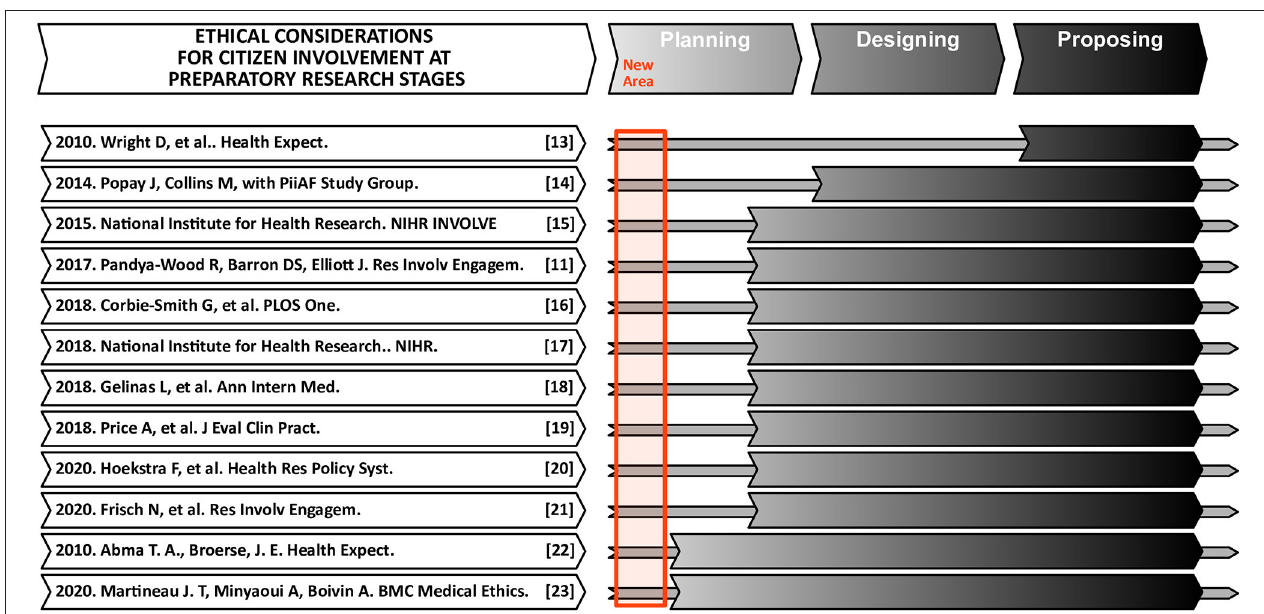
FIGURE 2 | The illustration lists a selection of 12 relevant publications, that directly or indirectly consider the ethical aspects of citizens involvement in research. Specifically, the list includes papers that discuss citizen involvement at preparatory stages of the research along a chronological axis (from planning, design, and submission, to approval of proposals). The involvement of citizens in executive stages of the research (conducting and implementing a project, or dissemination of results) is not addressed in the list. As evident, none of the selected studies have considered the early involvement of citizens in new and emerging areas of science (like